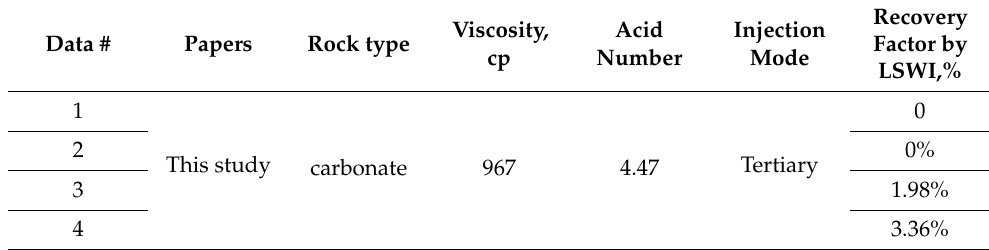
Table 6. Core flooding